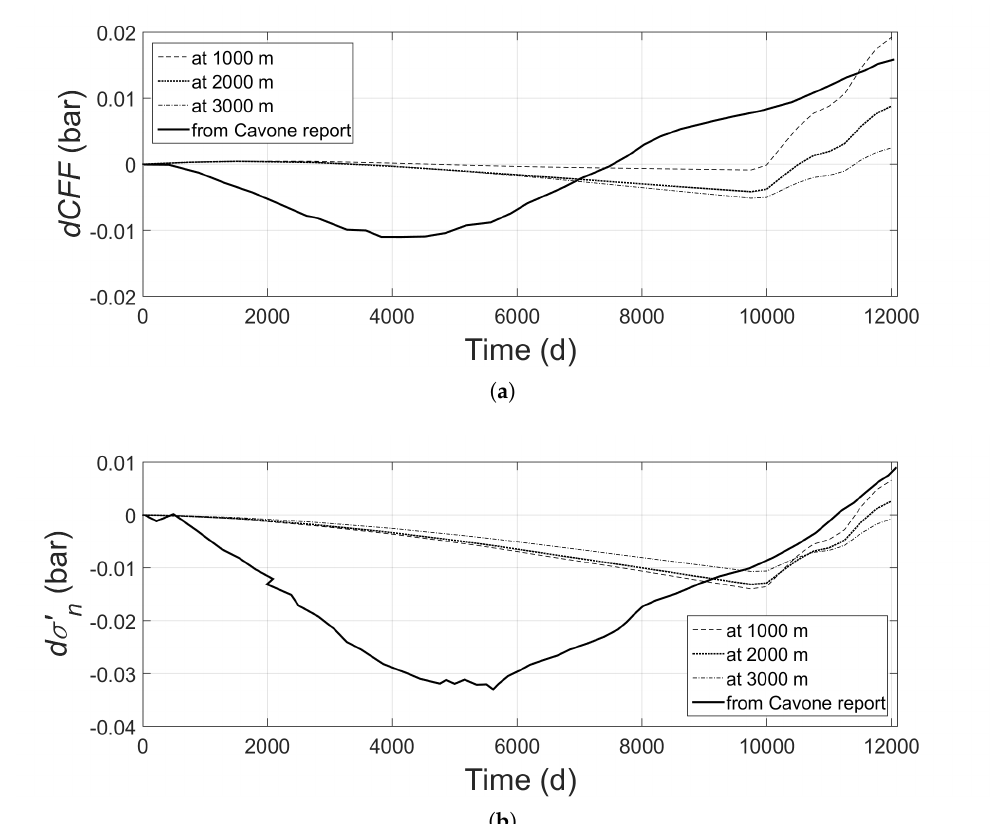
Figure 18. Emergent Mirandola fault and Cavone oilfield modeling: Coulomb stress change dCFF (bar) ( a ), and effective normal stress change d σ (cid:48) n (bar) ( b ) plotted for permeability of the lower caprock layer k lower = 0.1 mD at different distances from the hypocentre in the negative y -direction, on the hanging-wall block (see Figure 17).